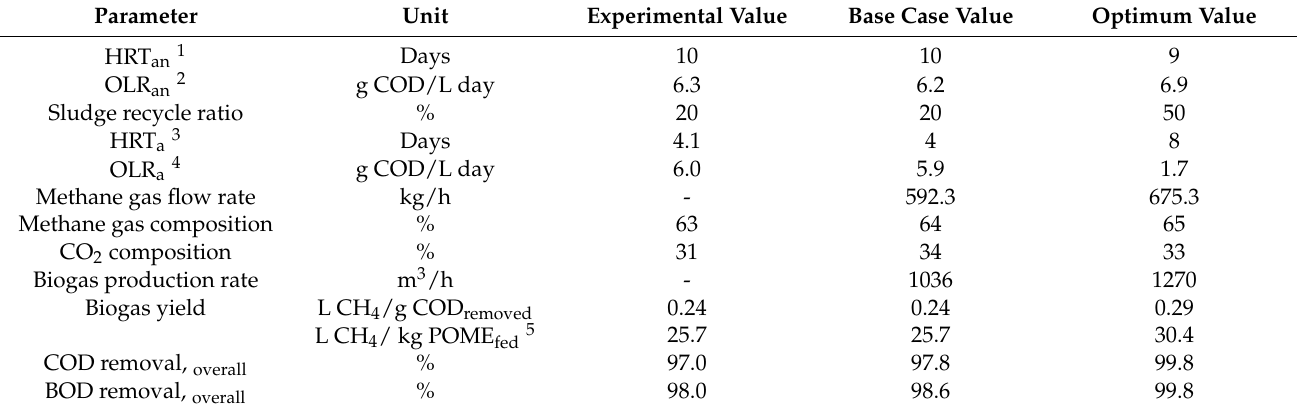
Table 3. Comparison of process parameters between base case and optimum